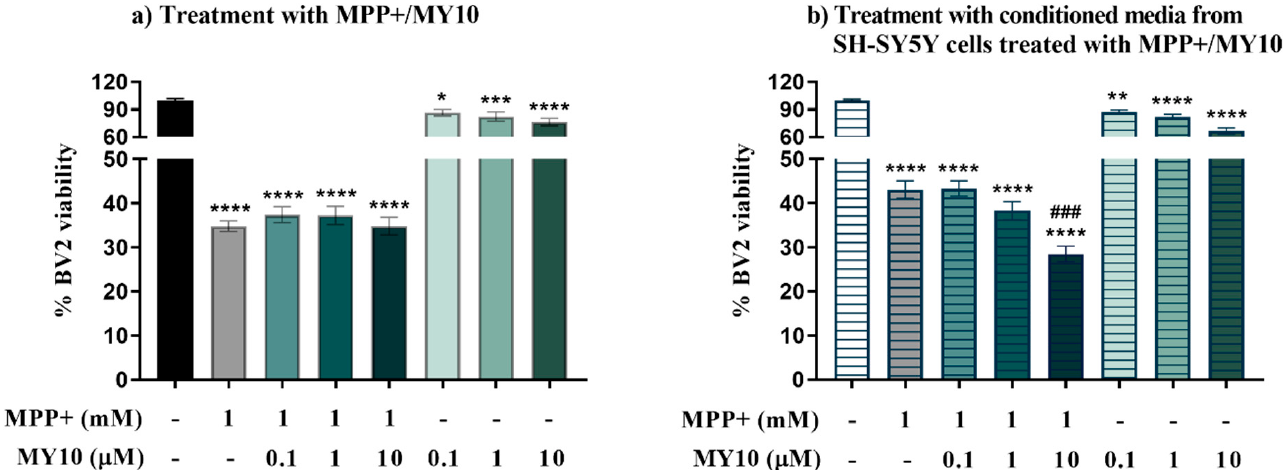
Figure 3. Pharmacological inhibition of RPTP β / ζ does not modulate MPP+-induced microglia injury but significantly aggravates the loss of microglia viability induced by conditioned media from MPP+-treated SH-SY5Y cells. ( a ) MPP+ causes a significant decrease in BV2 cell viability, which is not significantly modulated by MY10. Treatment with MY10 alone caused a significant reduction of microglial viability. ( b ) MY10 significantly enhances the loss of BV2 cells viability when microglial cells were incubated with the media from MPP+/MY10-treated SH-SY5Y cells. Treatment with conditioned media from SH-SY5Y-treated cells with MY10 alone causes a significant reduction of BV2 cell viability. Data are shown as % viability considering 100% viability of BV2 microglial cells incubated with complete media or with conditioned media from untreated SH-SY5Y cells (Controls, black bar and striped white bar, respectively). * p < 0.05, ** p < 0.01, *** p < 0.001, **** p < 0.0001 vs. untreated cells (Control). ### p < 0.001 vs.